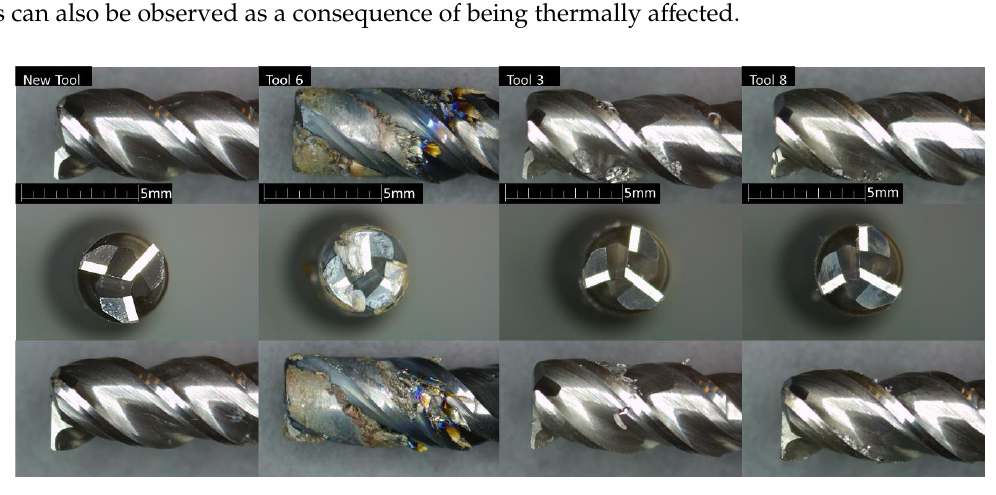
Figure 7. Tool wear after the test.